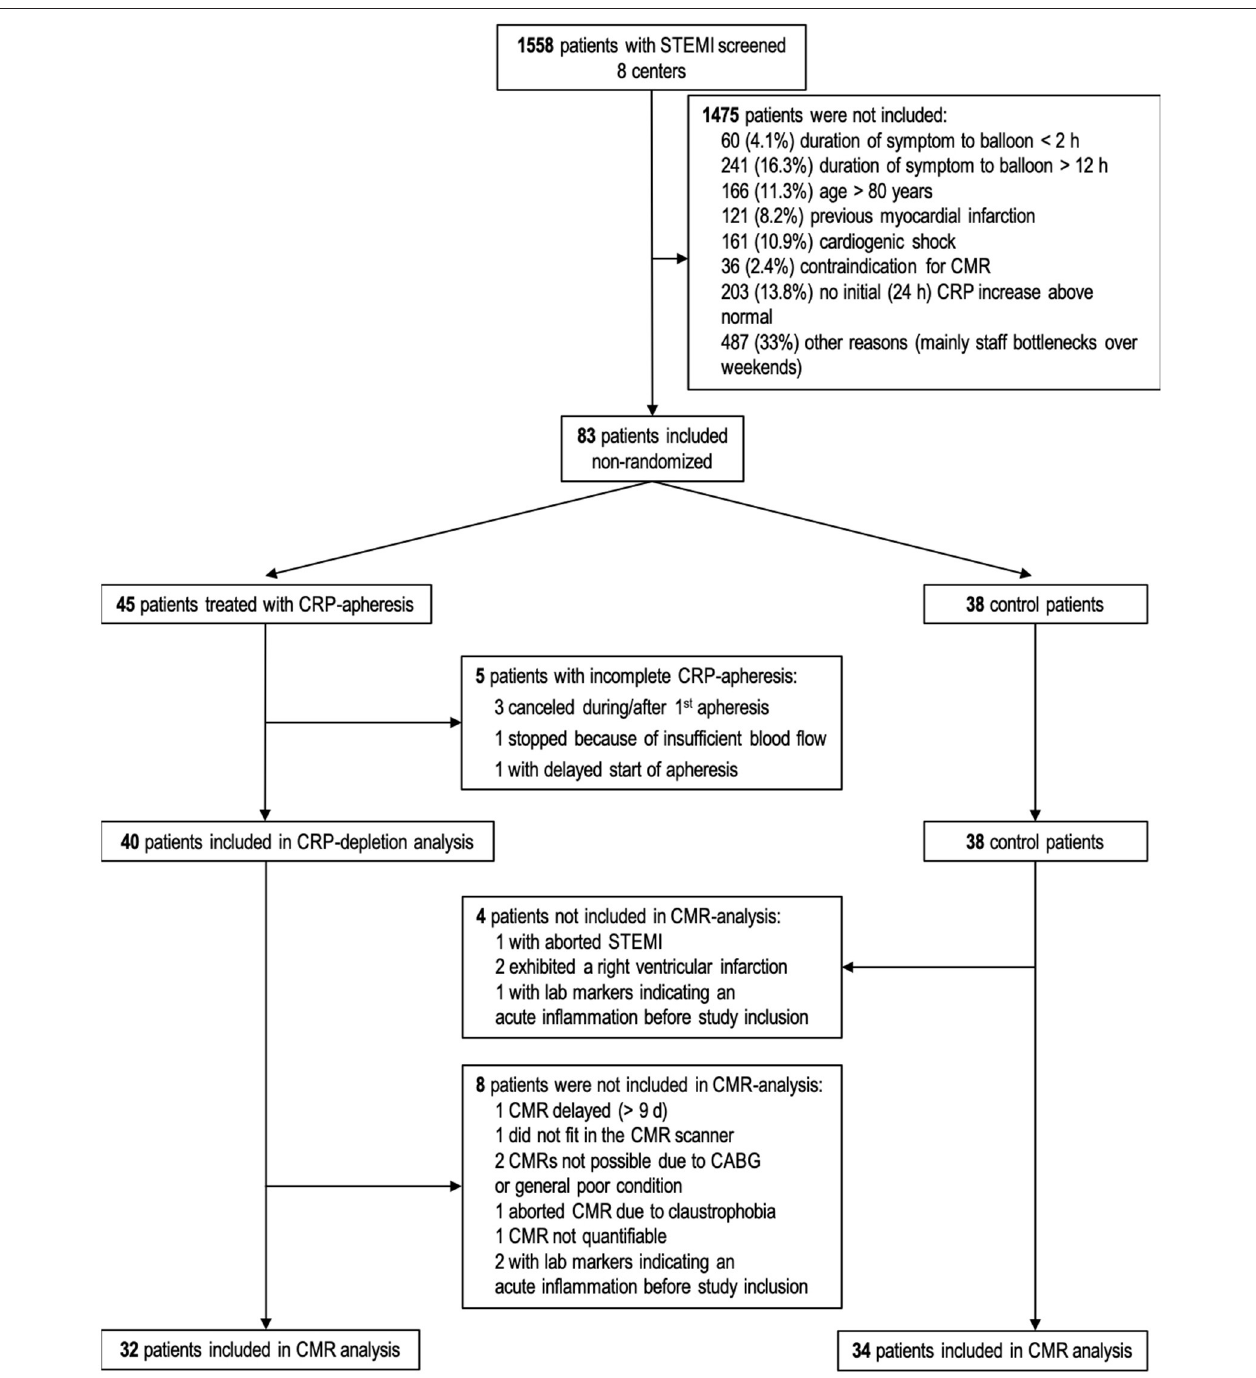
FIGURE 1 | Flow chart of patients’ recruitment and drop outs. Sixty-six patients (32 CRP apheresis group and 34 control group) attended final statistical analysis for CMR parameters. CABG, Coronary artery bypass graft; STEMI, ST-segment elevation myocardial infarction; CMR, cardiac magnetic resonance; CRP, C-reactive